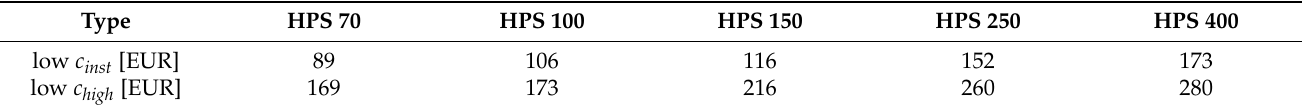
Table 9. The cost of dimming equipment installation. Table 8. The price range of new HPS luminaires at the local market.